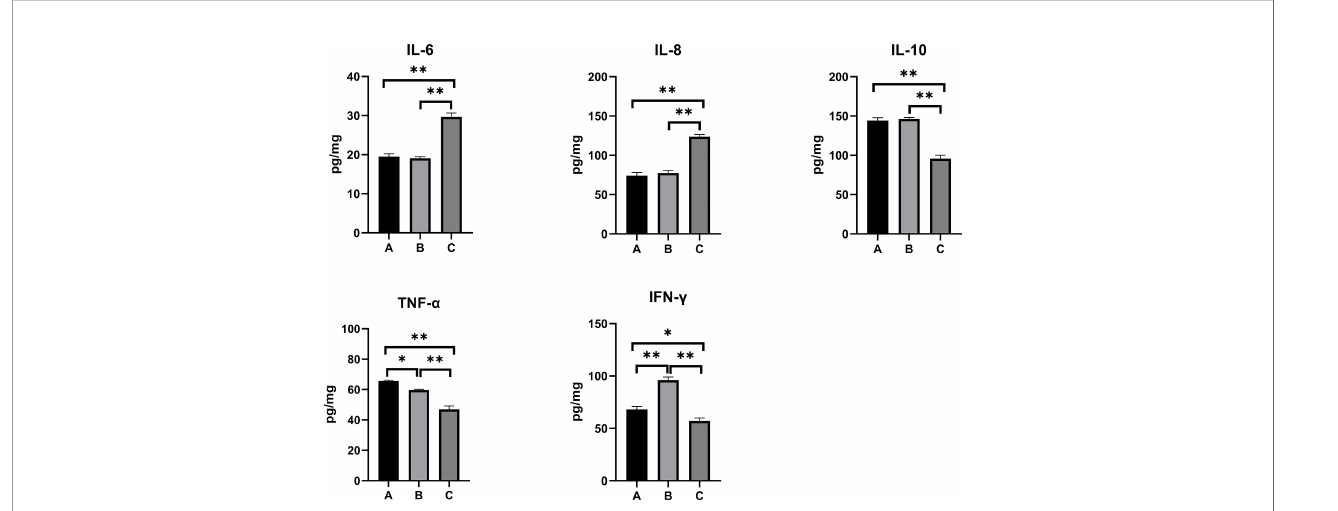
FIGURE 6 | Effects of OTA and AFB1 on kidney cytokines (IL-6, IL-8, IL-10, TNF- a , and IFN- g ) of pullets after 42 days (n = 6, mean ± SEM). Groups A, B, and C are the control group, the pair-feeding group, and the OTA+AFB1 group, respectively. Data were analyzed with ANOVA and Tukey ’ s HSD, and signi fi cant differences were de fi ned as * p < 0.05 and ** p < 0.01. OTA, ochratoxin A; AFB1, a fl atoxin B1; HSD, honestly signi fi cant